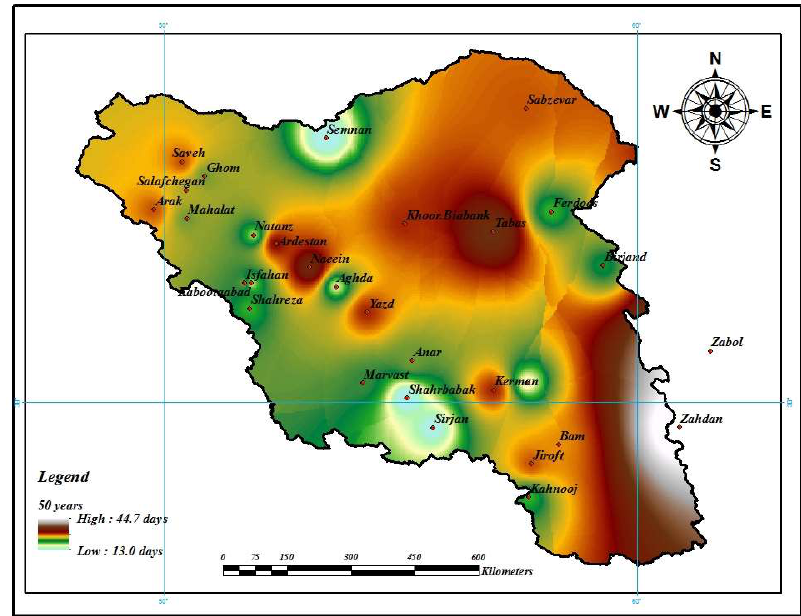
Figure 15. Dust day duration in the 50-year return period in the study area.